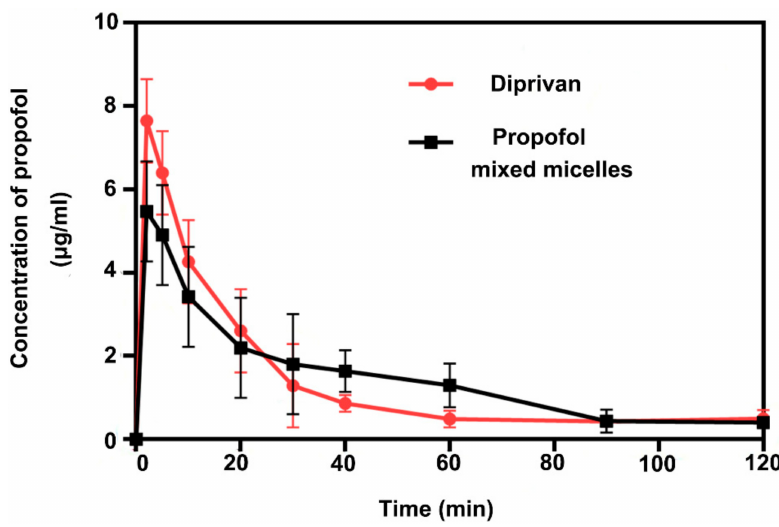
Figure 8. Plasma concentration of propofol vs. time for propofol-mixed micelles and Diprivan following intravenous administration (means ± SD, n =